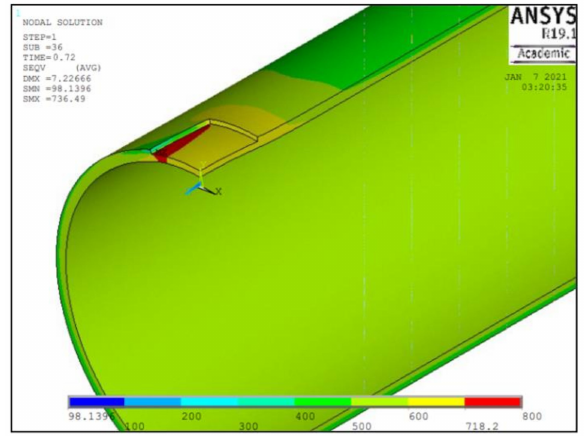
Figure 6. Red contour depicting the region of failure of the